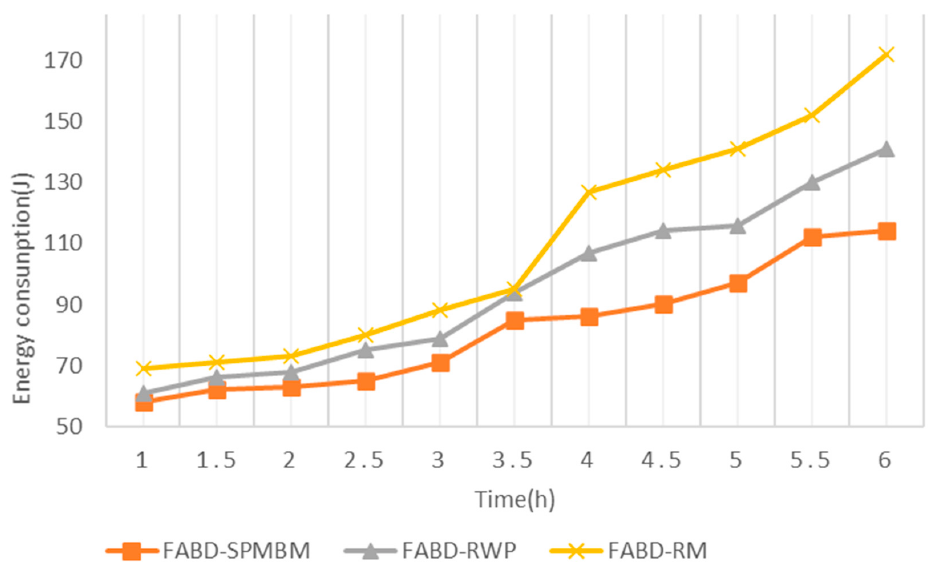
Figure 14. The energy consumption of FABD under different mobile models.